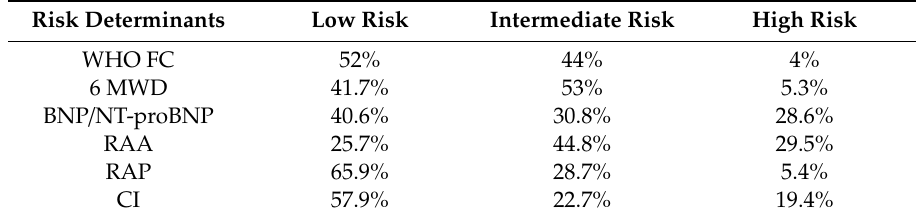
Table 3. Proportions of Prevalent Patients with Risk Determinants of Pulmonary Arterial Hypertension Mortality in their Low, Intermediate and High Risk